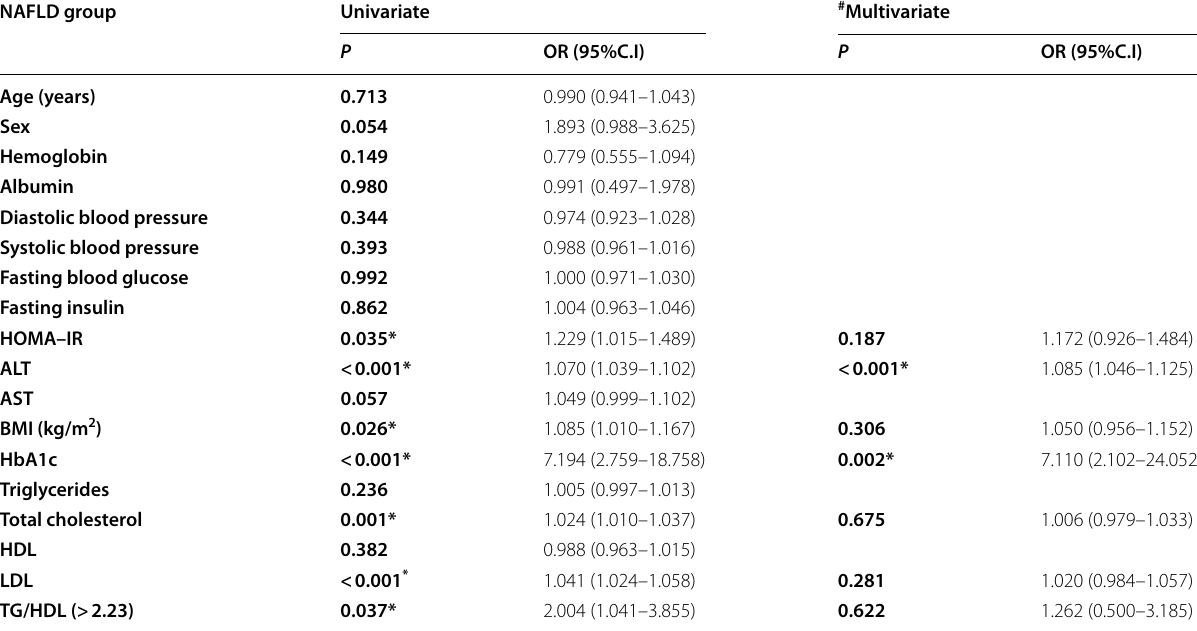
OR Odd`s ratio, C.I Confidence interval, BMI Body mass index # All variables with P < 0.05 were included in the multivariate analysis *Statistically significant at P ≤